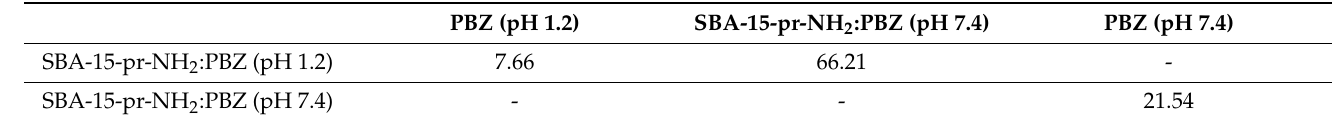
Figure 9. Dissolution profiles of SBA-15-pr-NH 2 :PBZ and PBZ. Table 5. Comparison of the similarity coefficients f2 between SBA-15-pr-NH 2 :PBZ and crystalline PBZ and between mesoporous silica in various pH.